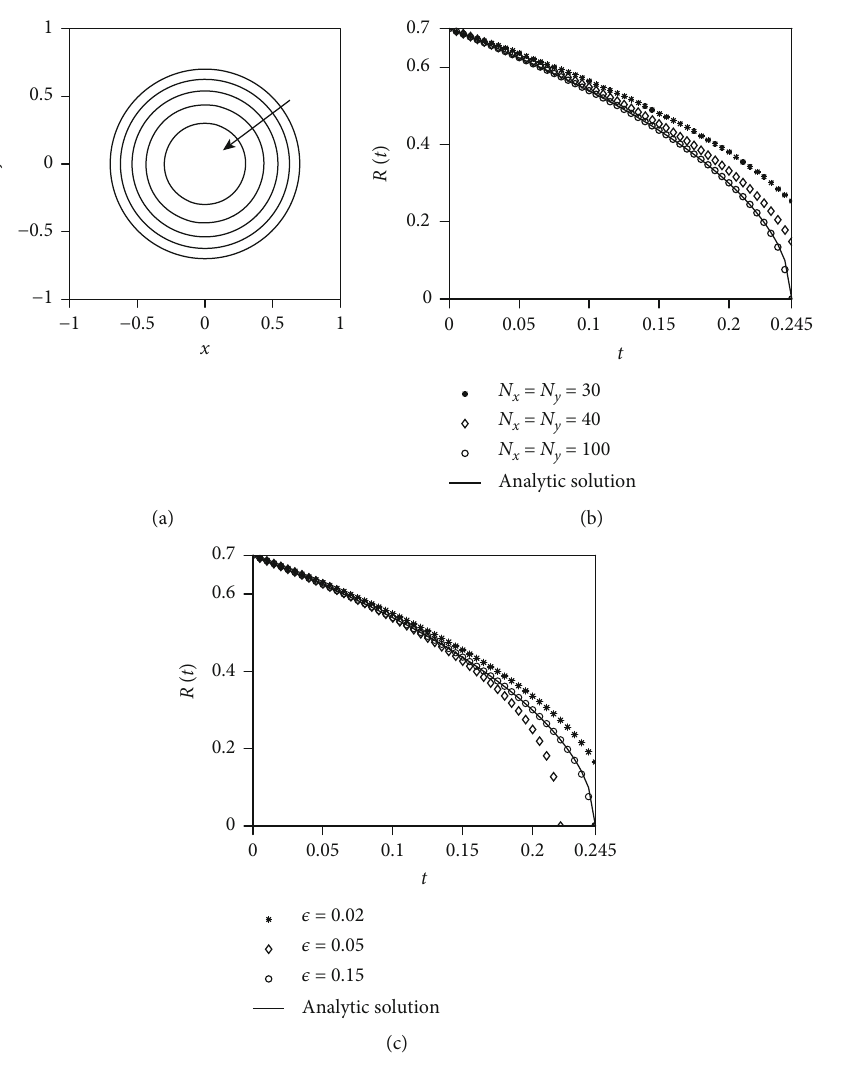
Figure 1: Given a circle (8), temporal evolution of (a) the zero level contour and (b, c) its radius R ð t Þ with di ff erent grid sizes and ϵ values,